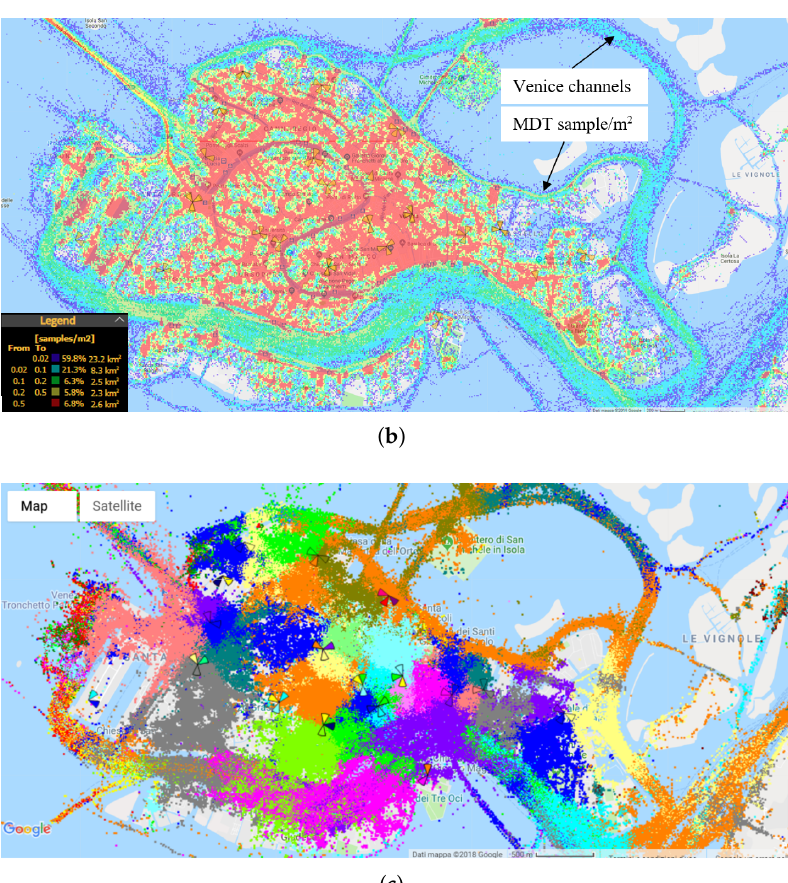
Figure 5. MDT georeferenced data from TIM live network on the area of Mestre and Venice cities. ( a ) MDT sample density (MDT sample/m 2 ) in the area of Mestre and Venice Cities (Italy) averaged over 24 h. On the map, each single visible point is a square pixel with 1 m side. ( b ) MDT sample density on Venice city. ( c ) MDT Best Serving Cell radio coverage of Venice Cities (Italy). Each colour identifies a single cell in the 1800 MHz frequency band. On the map, each single visible point is a square pixel with 1 m